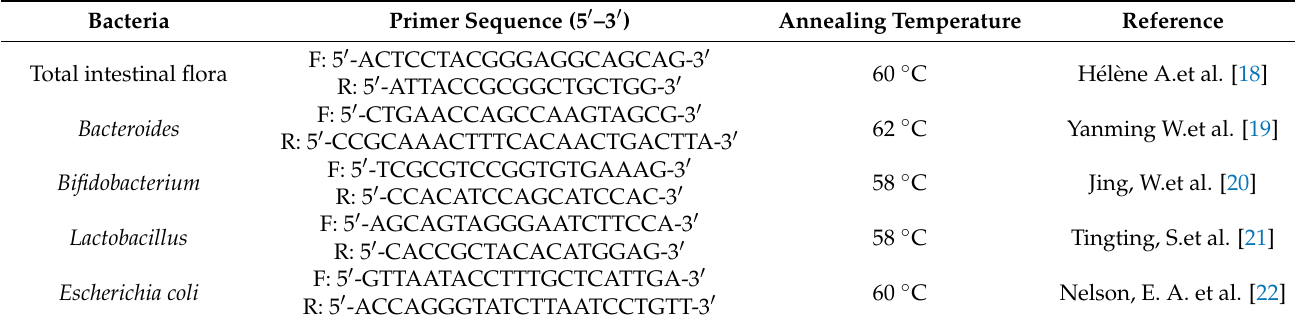
Table 1. Primer sequences of five